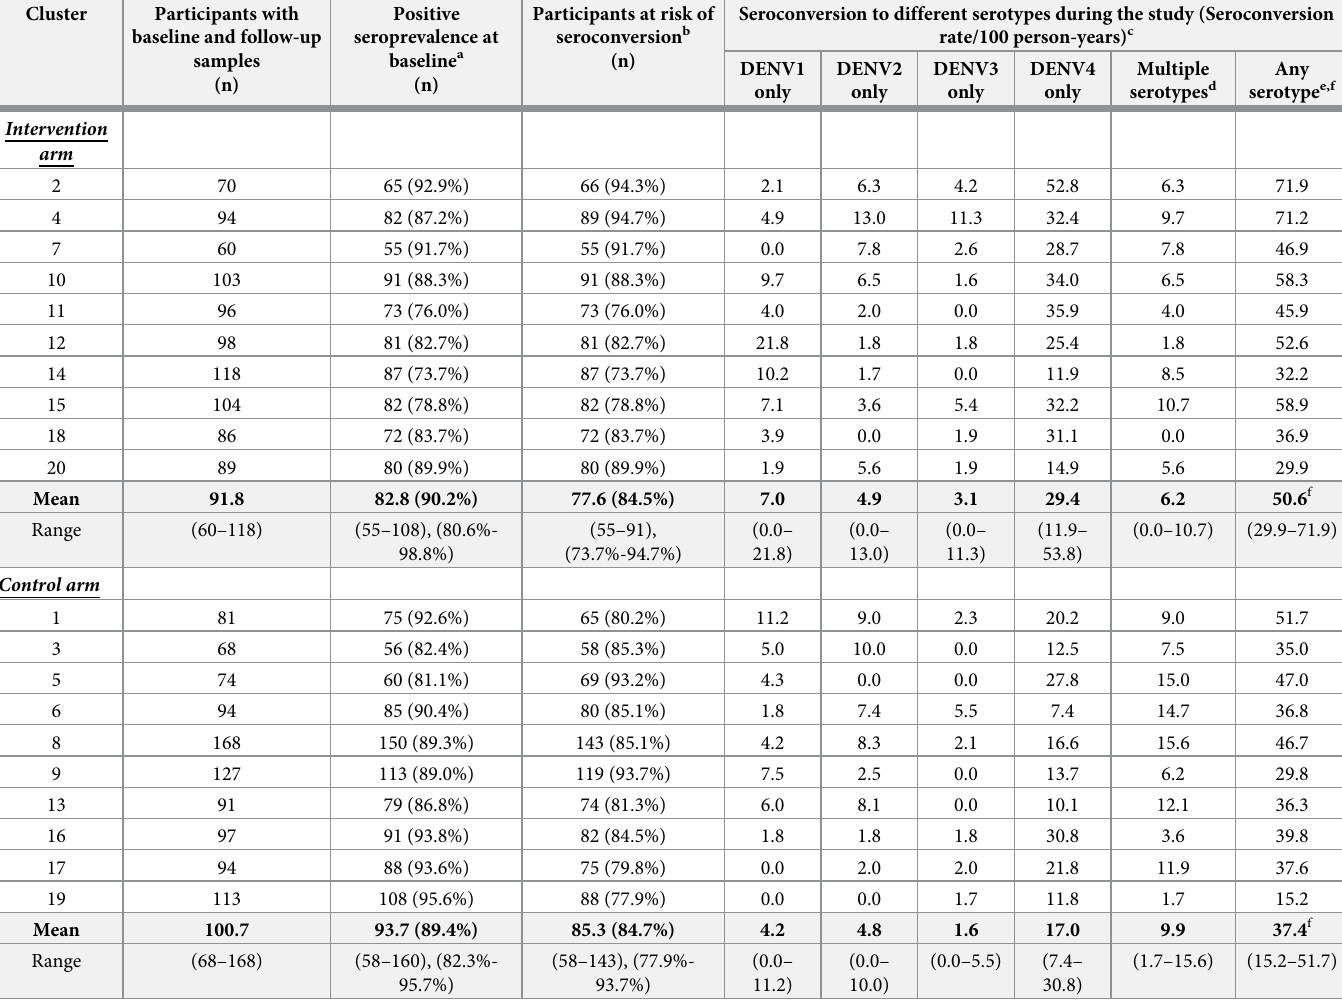
Table 2. Seroprevalence at baseline and seroconversion in intervention (n = 918) and control (n = 1007) arms. Cluster Participants with baseline and